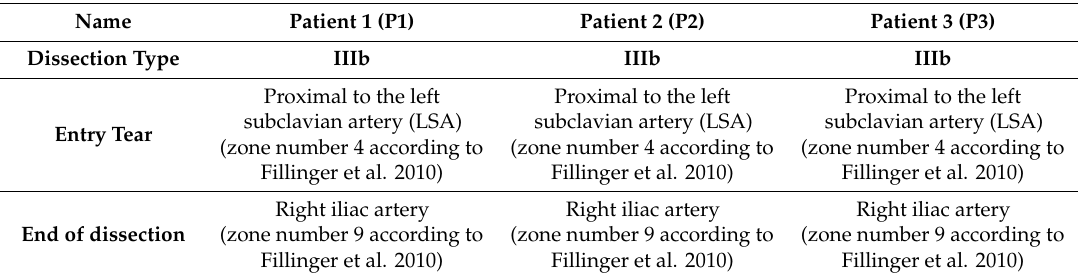
Table 1. Spatial configuration of analyzed patients. Dissection location according to Fillinger et al. 2010